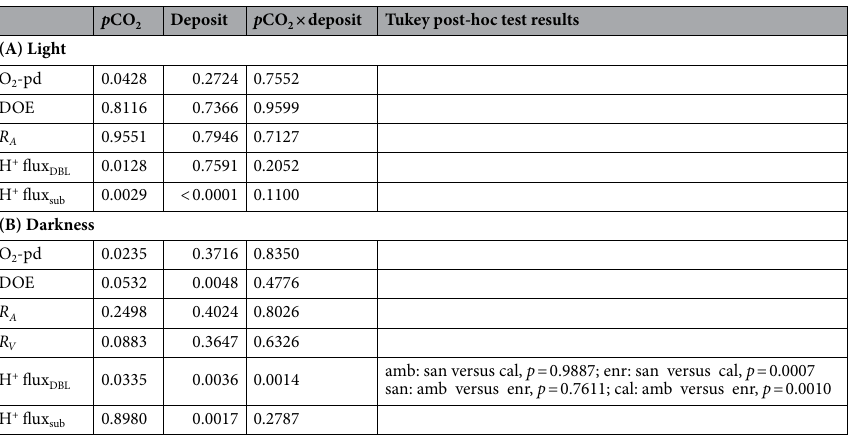
Table 3. Summary of two-way ANOVA p values in light and darkness testing for the effects of seawater p CO